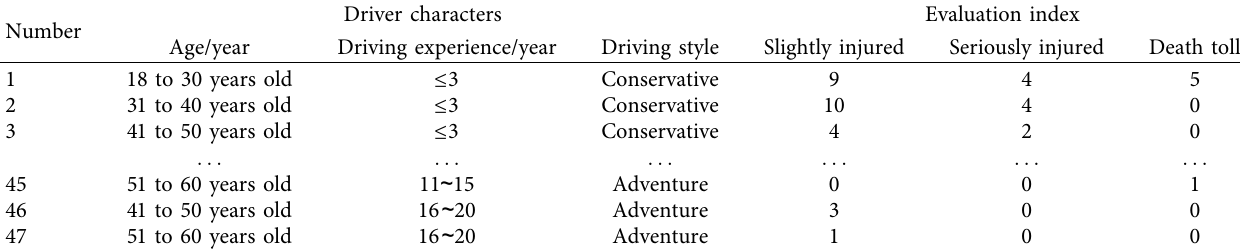
Table 1: Grouping of driver characteristics.